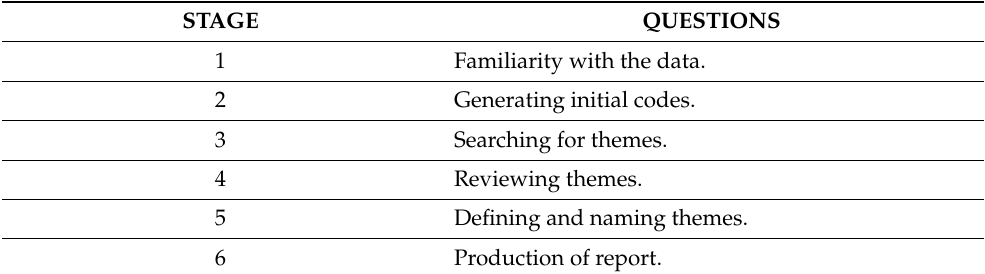
Table 3. Thematic analysis